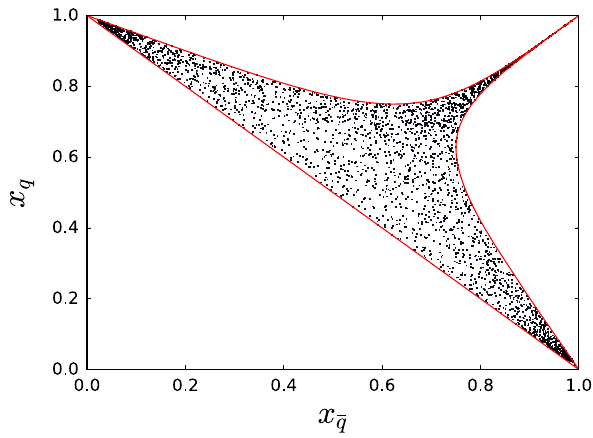
Fig. 3 Dalitz plot for e + e − → q ¯ qg showing the emission from the hard matrix-element correction into the dead-zone which is not pop- ulated by parton-shower emission. The line shows the limits for the parton-shower emission. x i = 2 E i / Q where E i is the energy of parton i and Q is the centre-of-mass energy of the collision